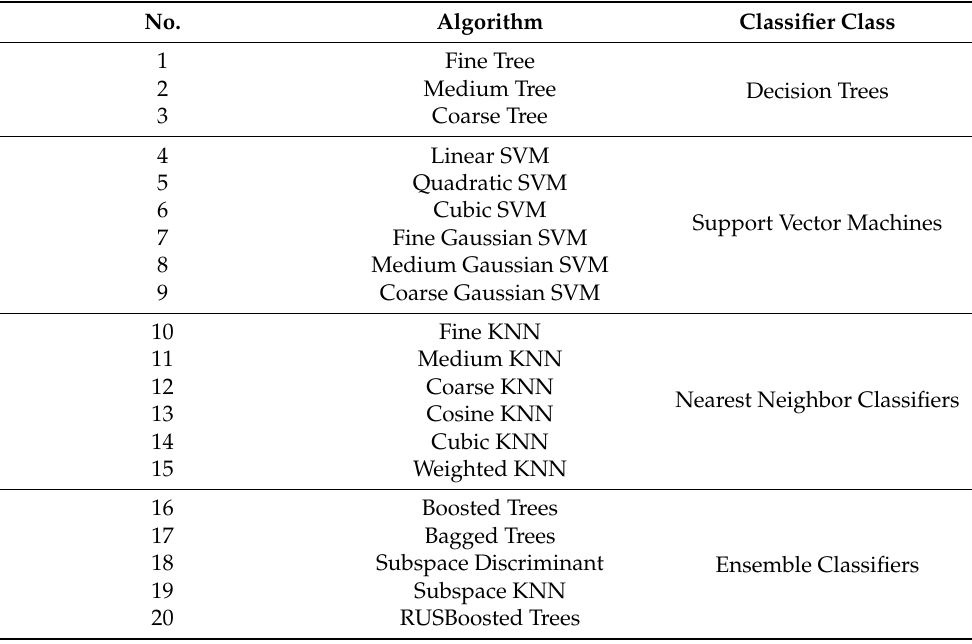
Table 3. Four classifier classes and 20 machine learning classification algorithms in the MATLAB classification learner